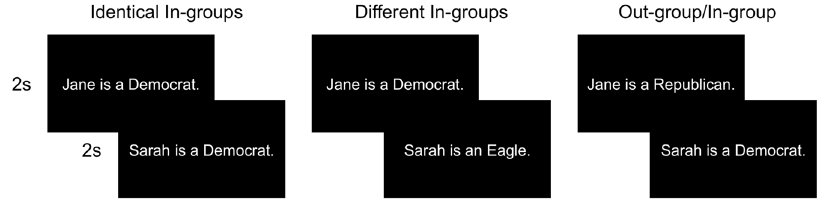
Figure 1. Task Stimuli. Trials consisted of pairs of statements, presented sequentially, in white font against a black background. The experiment included 3 condition types: ( a ) identical in-groups, ( b ) different in-groups, or ( c ) out-group/in-group. Each pair was followed by a 2s prompt that asked them, “How many of the people described were members of your